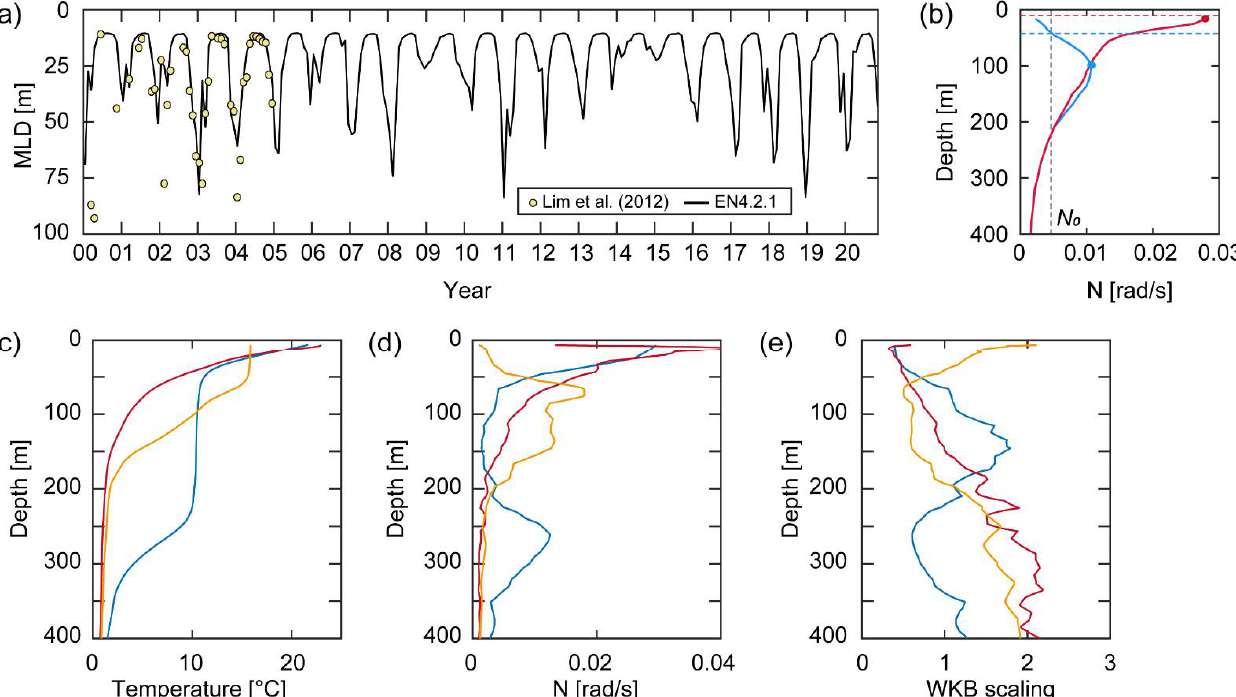
Figure 3. ( a ) Monthly mixed layer depth (MLD) estimated from EN4 (black line) data compared to that from Lim et al. [44] (yellow dot), ( b ) vertical structure of mean buoyancy frequencies, estimated from the EN4 data, at the upper 400 m nearby the EC1 mooring averaged over summer (June–July– August, red line) and winter (December–January–February, blue line) where the Nmax and MLD are remarked with circles and dashed horizontal lines with corresponding colours. Vertical dashed line in ( b ) indicates the depth-averaged reference N 0 (4.6 × 10 − 3 rad/s). Vertical profiles of ( c ) temperature, ( d ) buoyancy frequency and ( e ) WKB scaling factor observed using Argo floats located within 80 km from the EC1 (red, blue and orange lines were observed on 20 August 2014, 25 June 2015, and 23 December 2016,